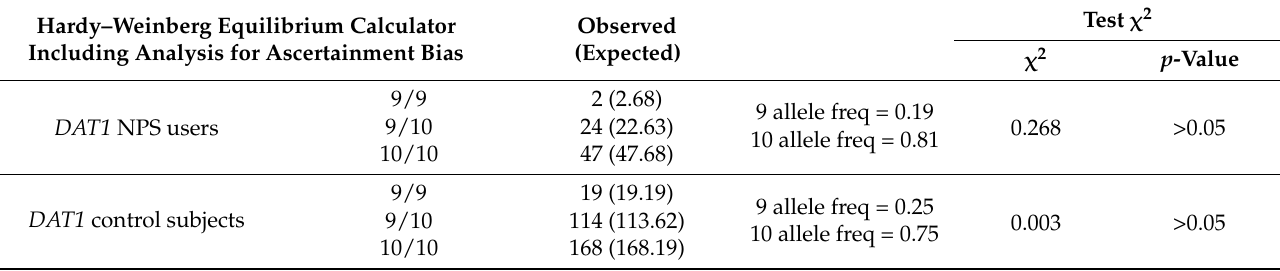
Table 1. Hardy–Weinberg law for the NPS users and control